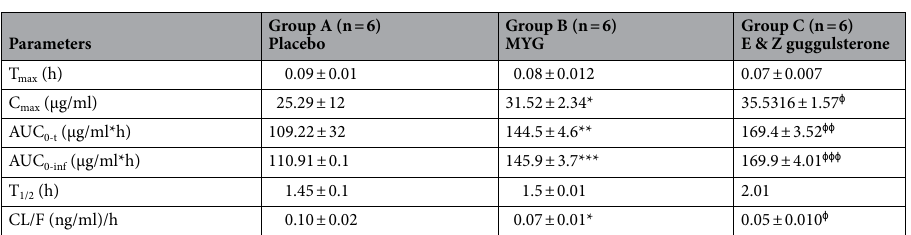
Table 2. Pharmacokinetic parameters of midazolam in rat plasma. Values are expressed in mean ± SD; (*) P < 0.05 Group A vs Group B; ( ɸ ) P < 0.05 Group A Vs Group C. T max time required to achieve maximum plasma concentration; C max maximum plasma concentration; AUC (0–24) area under concentration–time curve extrapolated to 24 h; AUC (0–∞) area under concentration–time curve extrapolated to infinity; CL/F total body clearance; t½